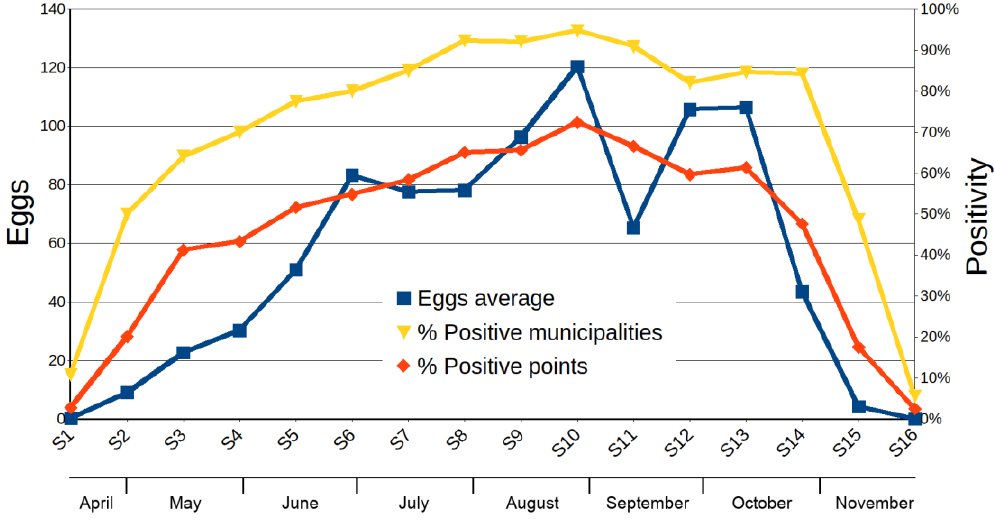
Figure 2. Fenology of aedes albopictus in the Region of Murcia, in 2019.